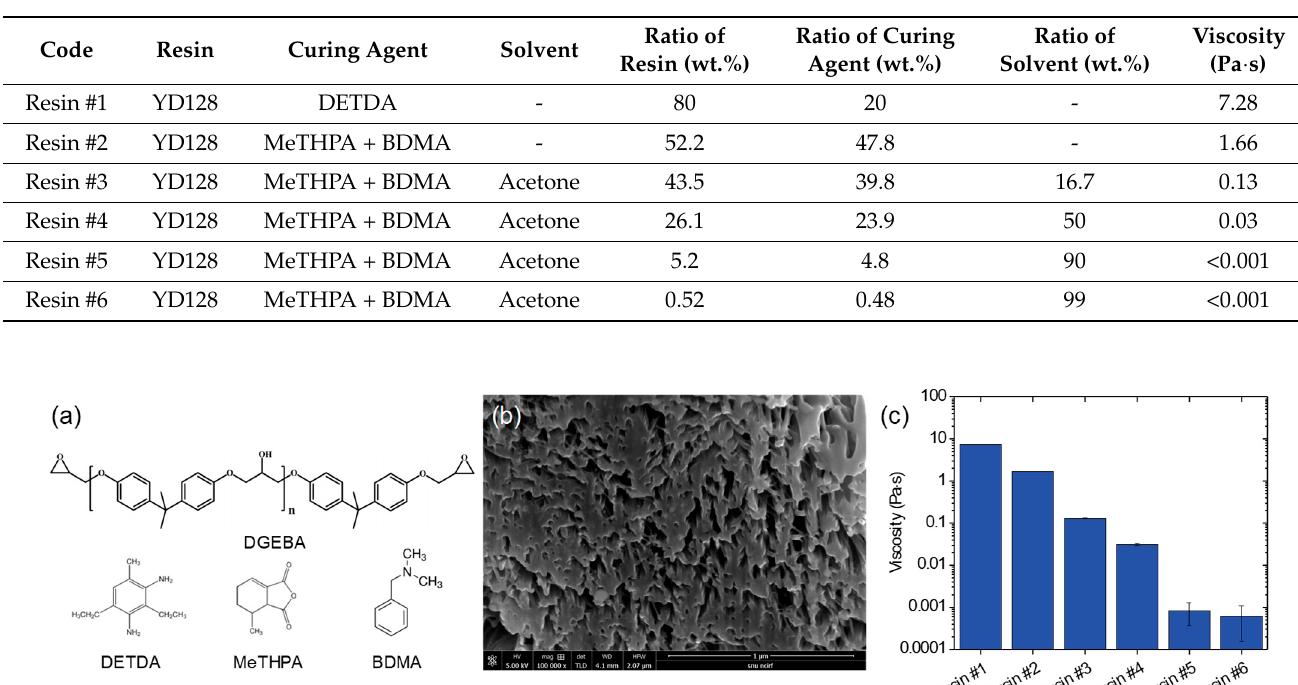
Table 1. Summary of the epoxy resin systems used in this work.